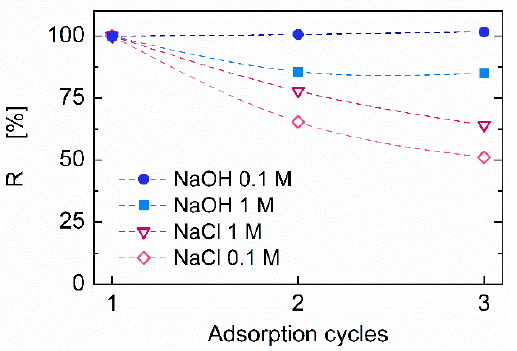
Figure 6. Cyclic adsorption capacity of CS–ZX aerogels for IC (full symbols) and MB (open symbols). Dye concentration of each adsorption cycle was C 0 = 200 mg L − 1 .